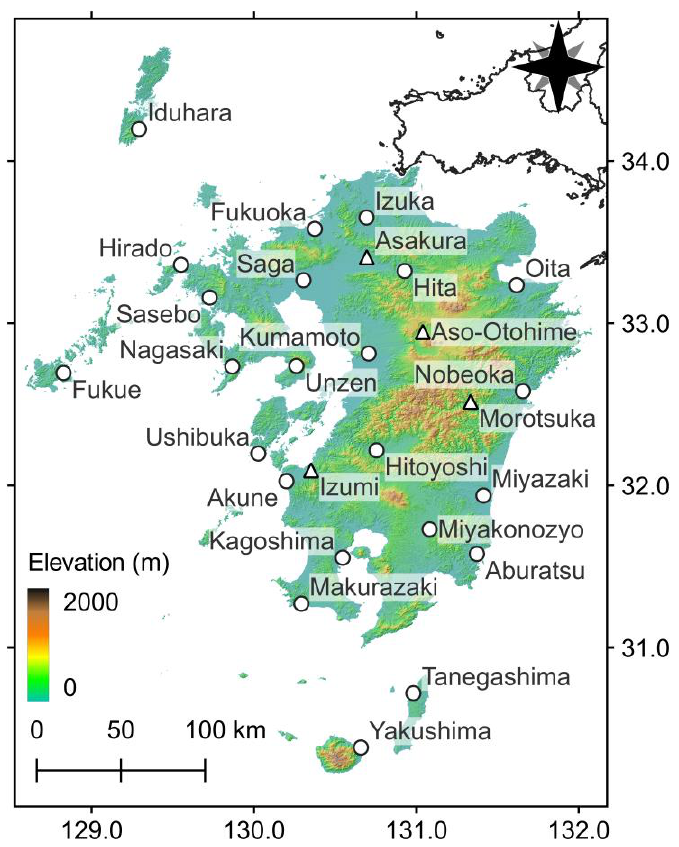
Figure 1. Location of rainfall stations. White circles and triangles indicate meteorological observa- tories and AMeDAS, respectively. Table 1. Specifications of meteorological observatories in Kyushu.